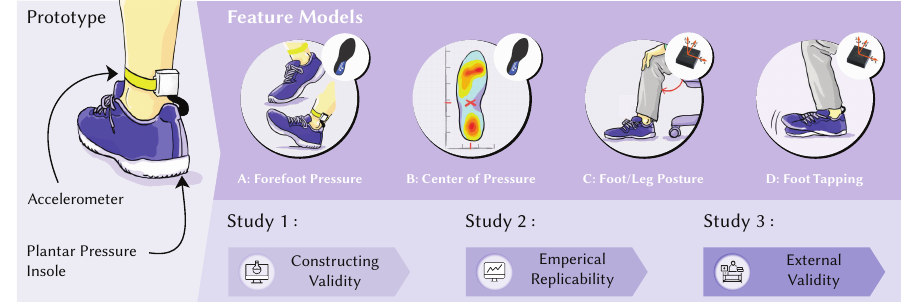
Figure 3. To detect acute stress, we present a shoe prototype incorporating a pressure sensitive insole and an IMU worn around the ankle. Based on literature research and observations, we propose four features that can reveal the user’s stress level. We show that a significant forefoot pressure, deviations in the centre of pressure, different foot/leg postures, and tapping of the foot, can indicate an